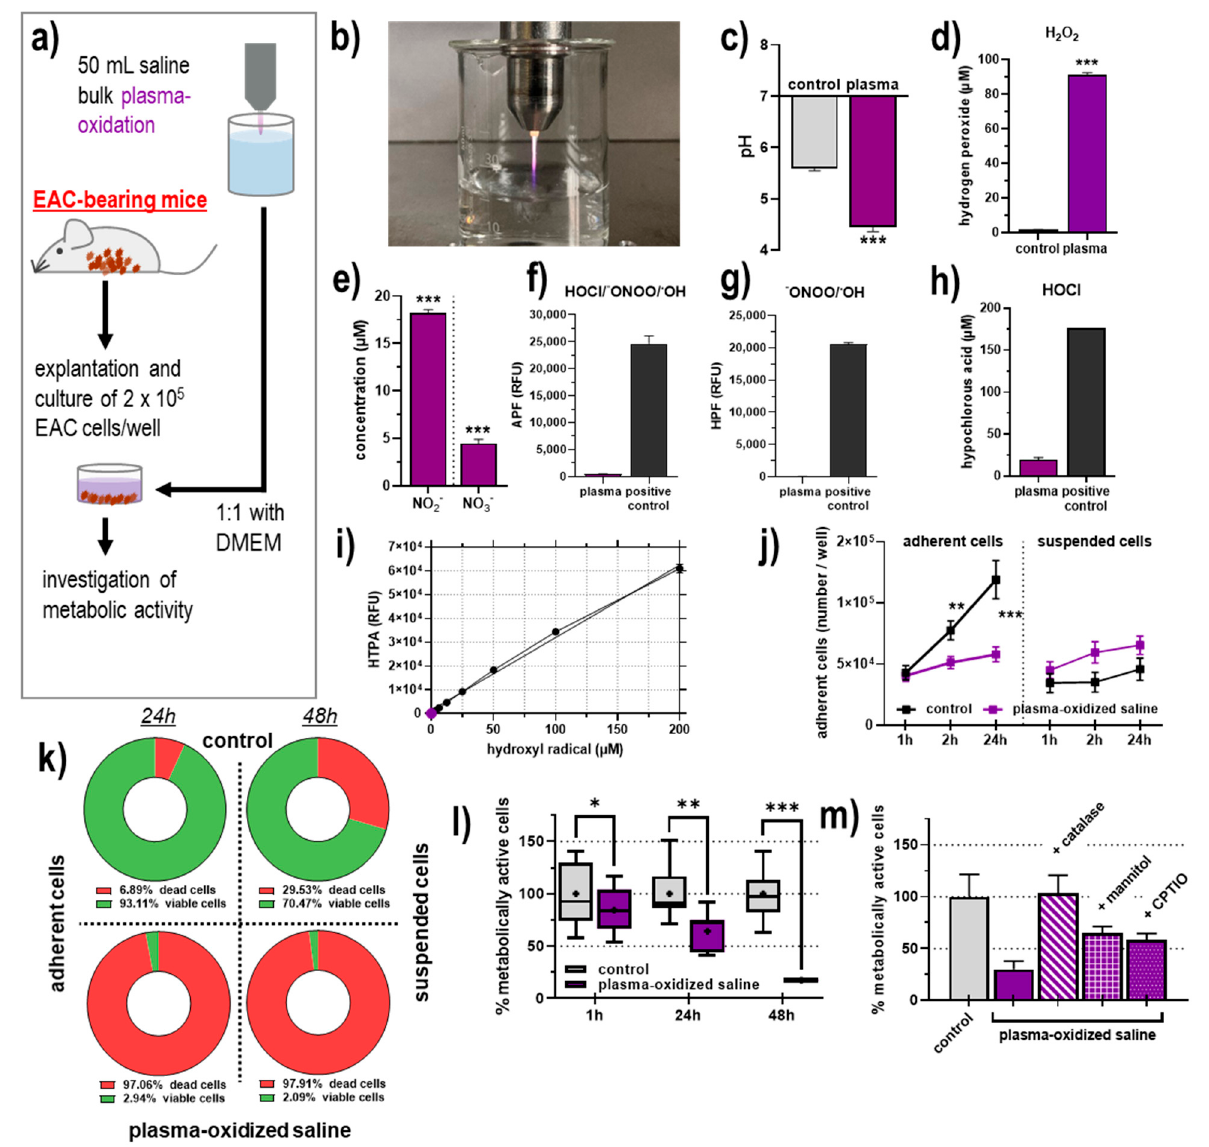
Figure 1. Plasma-oxidized saline reduced the metabolic activity of EAC cells ex vivo. ( a ) Schematic overview of experi- mental procedures; ( b ) representative image of kINPen plasma oxidation of 20 mL saline; ( c ) pH in plasma-oxidized saline; quantification of ( d ) hydrogen peroxide (H 2 O 2 ), ( e ) nitrite (NO 2 − ), and nitrate (NO 3 − ) in plasma-oxidized saline; relative fluorescence intensity (RFU) of oxidized ( f ) APF and ( g ) HPF due to respective species in plasma-oxidized saline, direct treatment of the redox sensitive probes served as positive control for production of reactive species; quantification of ( h ) hypochlorous acid (HOCl) and ( i ) hydroxyl radical ( • OH) in liquids, plasma treatment with HeO 2 as feed gas was used as a positive control for HOCl production; ( j ) number of viable adherent EAC cells after explantation and incubation with either plasma-oxidized saline or untreated saline for 48 h; ( k ) percentage of adherent cells after 24 h and 48 h of POS treatment; ( l ) metabolic activity of EAC cells 1 h, 24 h, and 48 h post-incubation of plasma-oxidized or untreated saline; ( m ) metabolic activity of EAC cells 48 h after incubation with untreated or plasma-oxidized saline with the antioxidants catalase, mannitol, and cPTIO. Data are mean ± SEM of at least three independent experiments, statistical analysis was performed using t -test or one-way ANOVA with p < 0.05 (*), p < 0.01 (**), and p < 0.001 (***). EAC = Ehrlich Ascites Carci- noma; HTPA = hydroxyterephthalate; APF = fluorescence response of 3 ′ (p-aminophenyl) fluorescein; HPF = (p-hydroxy- phenyl) fluorescein.